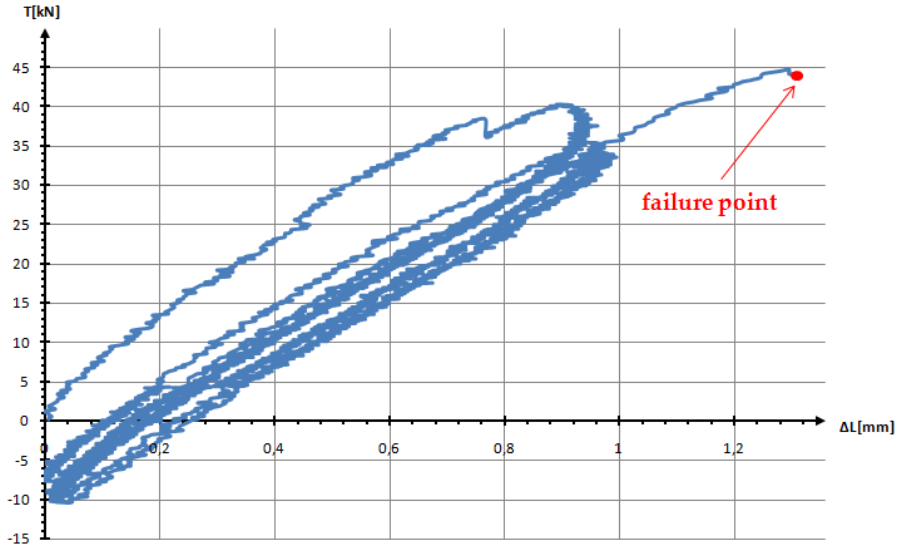
Technologies 2016 , 4 , 20 Figure 16. Load versus elongation graph—joint sample “I”. Figure 16. Load versus elongation graph—joint sample “I”.